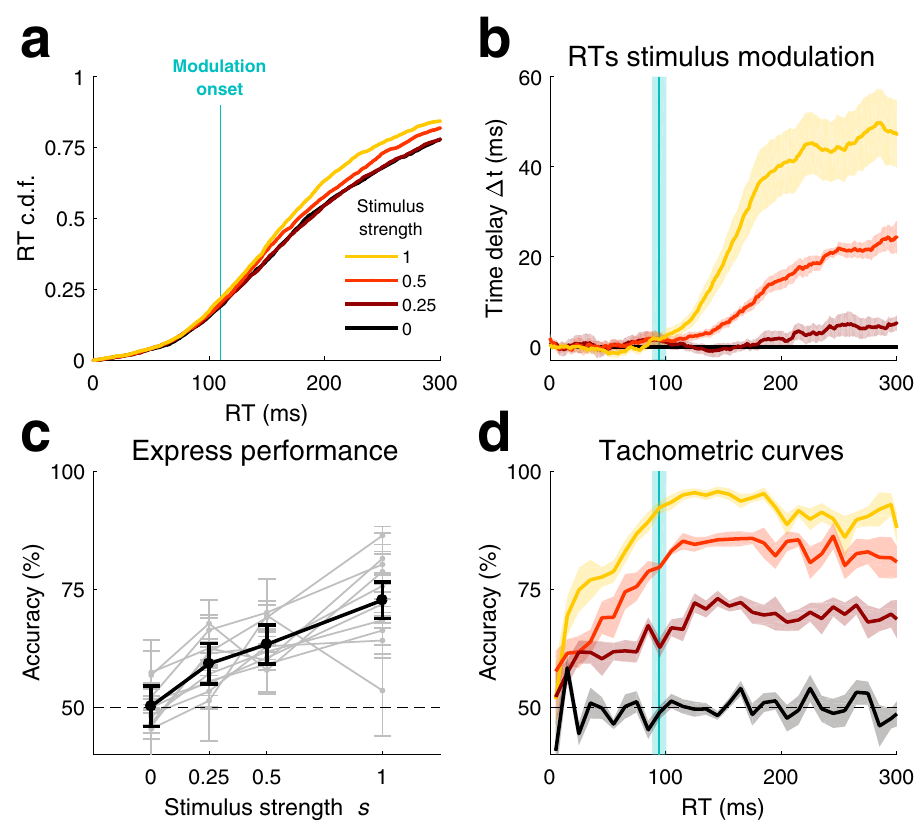
Fig. 2 Decoupled reaction times and choices for express responses. a RT cumulative distribution function (RT cdf) for different values of stimulus strength for an example animal (rat #11) in unbiased trials. Vertical line indicates the onset of the stimulus modulation on RT cdf computed for this rat (see “ Methods ” ). b Mean time delay curves for RT cdf in the frequency discrimination task, averaged across rats (Group 1, n = 10). Trials with uninformative stimulus (stim. strength s = 0) are used as reference (i.e. time delay Δ t = 0 for s = 0). Vertical line represents the mean modulation onset time (95 ms). Shaded areas: standard error of the mean (s.e.m). c Accuracy on trials with RTs shorter than 50 ms as a function of stimulus strength s . Thick line denotes the group average across the same rats as in panel ( b ); thin lines represent individual rats. Error bars represent s.e.m. d Tachometric curves, i.e., accuracy as a function of reaction times 16 , for different stimulus strength s values, averaged across rats. Reaction times were binned in windows of 10 ms. Vertical line: mean RT-stimulus modulation onset. Shaded areas: s.e.m. Source data are provided as a Source data fi